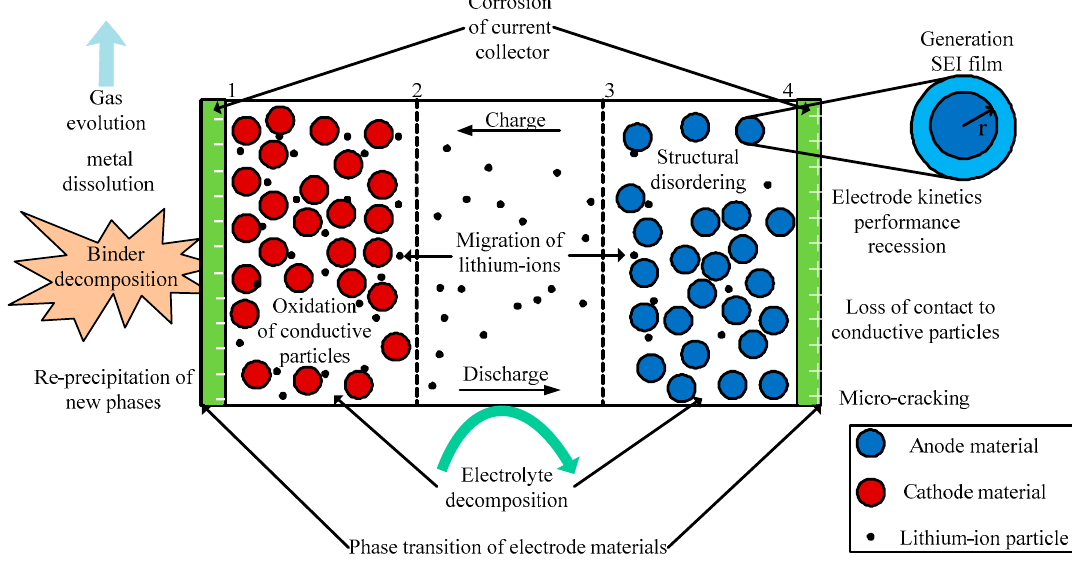
Figure 1. Basic schematic of lithium-ion battery aging.